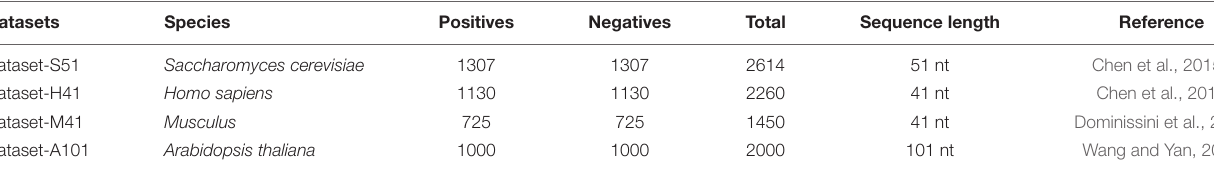
TABLE 1 | Summary of the benchmark datasets from four species.